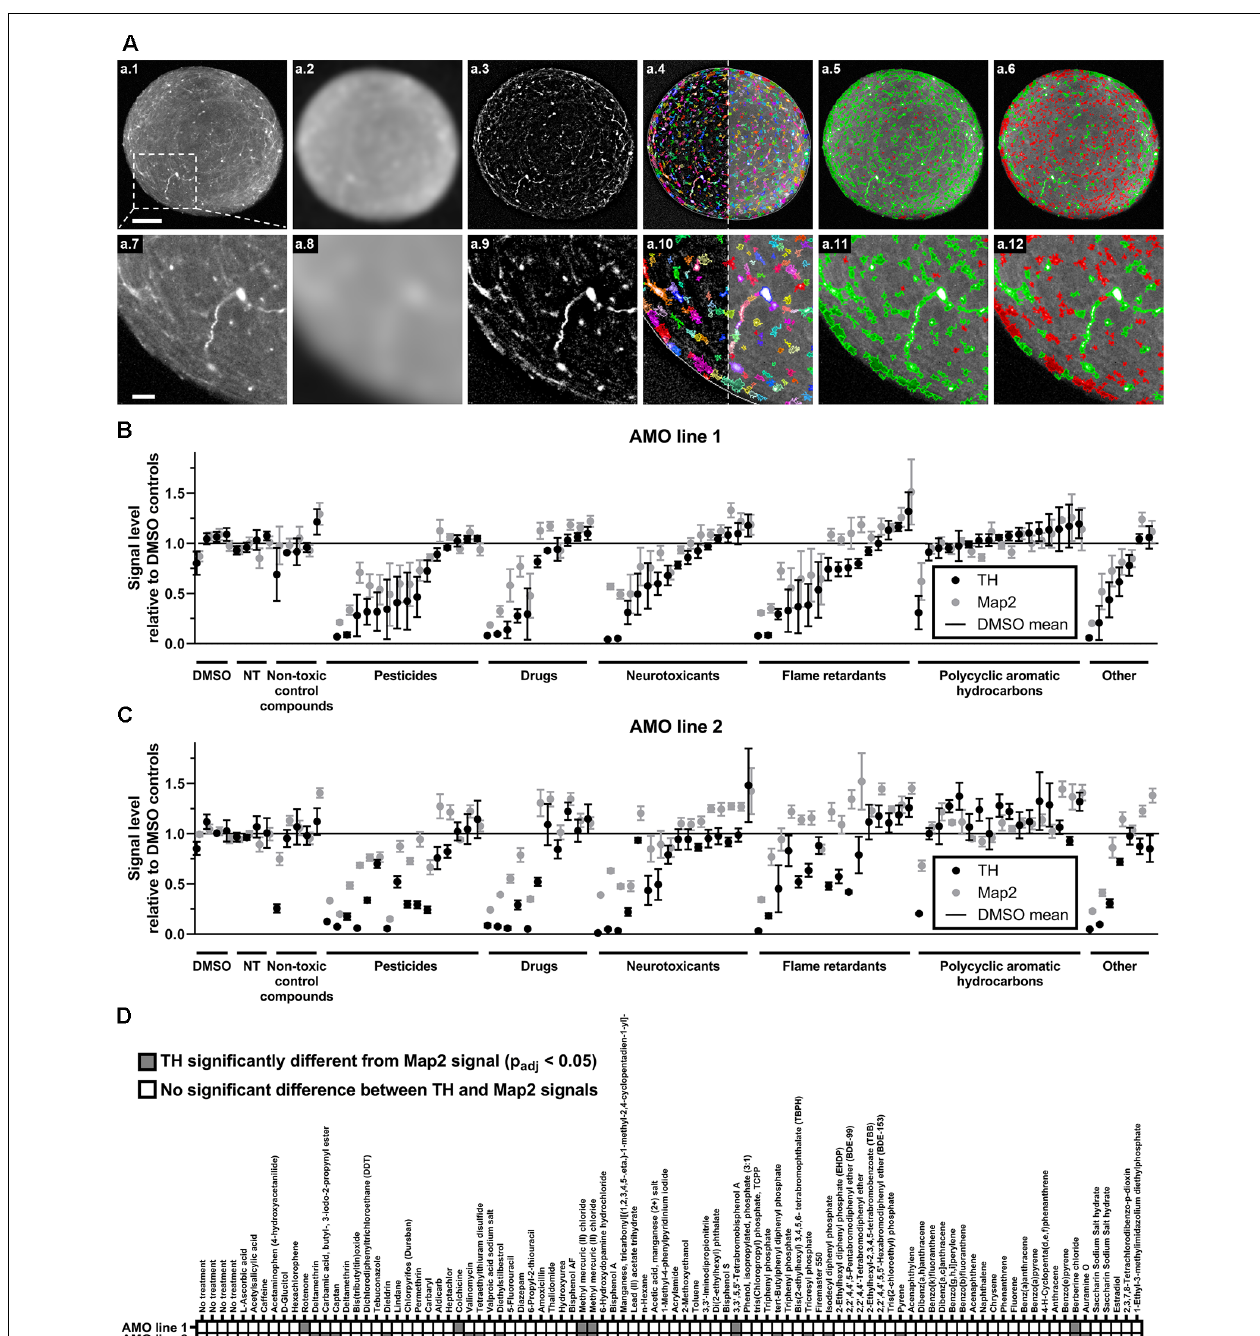
FIGURE 3 | High content image analysis quantified cell-type-specific toxicity in 3D human midbrain-like tissues. (A) Outline of the high content image analysis workflow we used to quantify organoid-resident cellular subpopulations for the example of tyrosine hydroxylase (TH)-positive cells. Images represent a single confocal plane through the center of a whole-mount-stained and cleared AMO. The top row (A.1–A.6) shows the entire organoid while the bottom row (A.7–A.12) contains enlarged sections from the same AMO (A.1/A.7) . Raw starting image of the TH channel (A.2/A.8) . The TH channel after Gaussian smoothing. (A.3/A.9) The TH channel after subtraction of the Gaussian-smoothed image to reduce background (background-corrected channel, BC). (A.4/A.10) Putative TH+ regions of interest (ROIs) overlaid on the BC (left of the dotted line) and raw TH channels (right of the dotted line). ROIs were identified on the BC image. (A.5/A.11) TH+ ROIs selected based on their size and brightness (green) and rejected ROIs (red). (A.6/A.12) Adjustment of the selection criteria to only include the brightest ROIs (green) and discard all others (red). Scale bars: 100 µ m (A.1) , top, 25 µ m (A.7) , bottom. (B,C) Compound treatment induced a wide range of changes within the dopaminergic (TH+, black dots) and general (Map2+, gray dots) neuronal cell populations in AMOs. Data represent mean integrated brightness values of